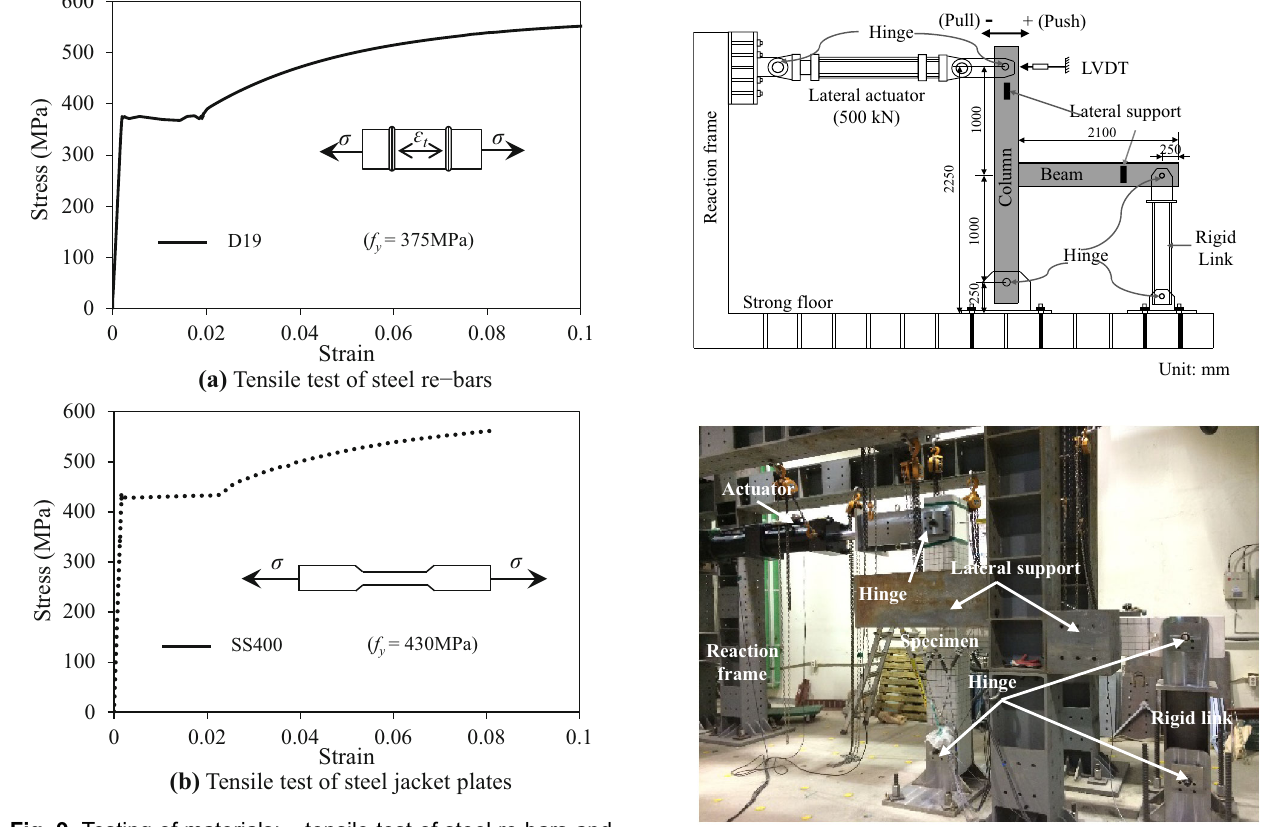
Fig. 9 Testing of materials: a tensile test of steel re-bars and b tensile test of steel jacket